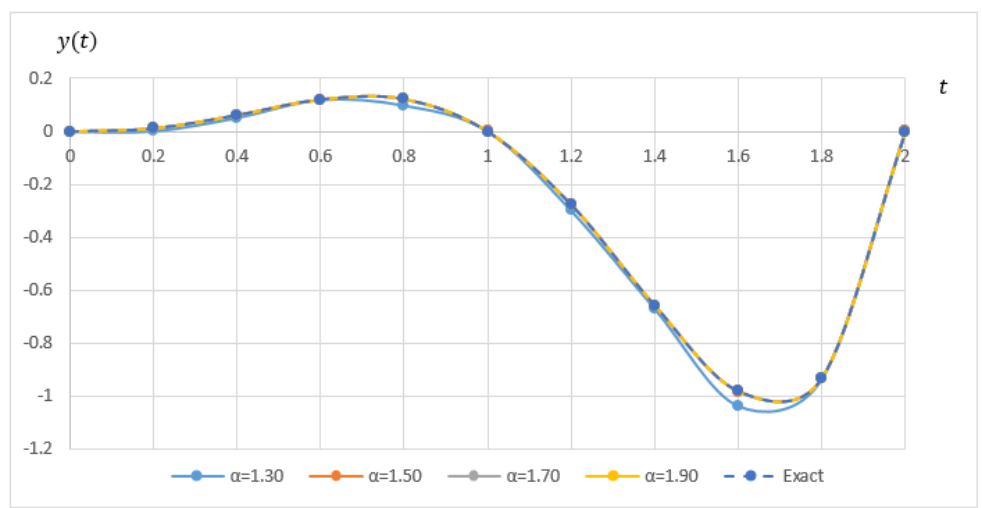
Figure 9. Approximate solution, y ( t ) against each point, t of different α at N = 100 when solving Example 5 using FEAM3.